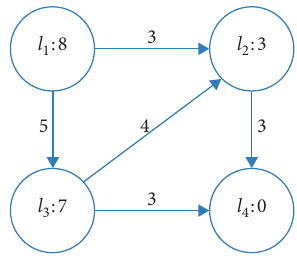
Figure 1: Example of position-position transition diagram (LLTG diagram).